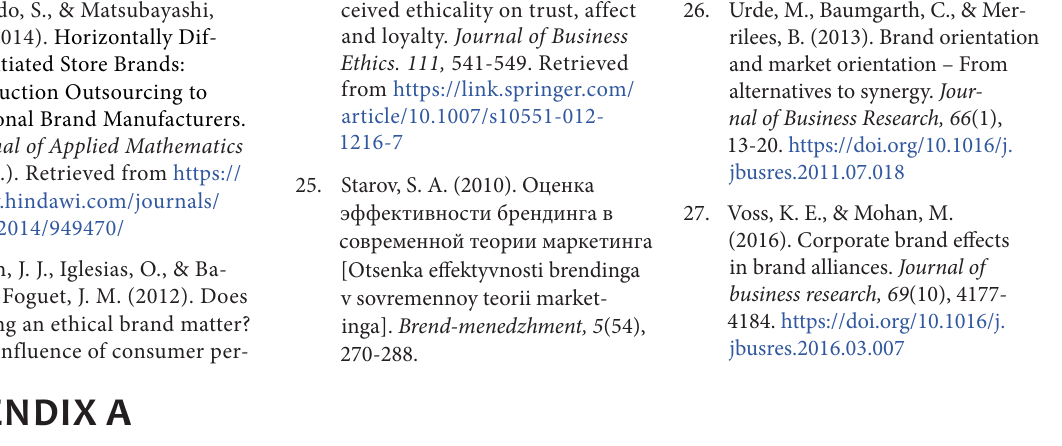
Table A1. A set of partial indicators to assess the complementary effect from brand integration in